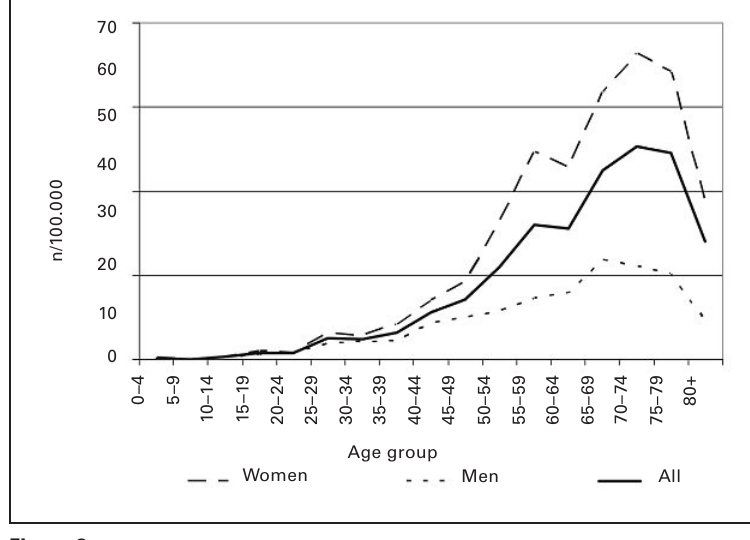
Annual mean incidence per 100,000 inhabitants of parathyroidectomy in Switzerland,